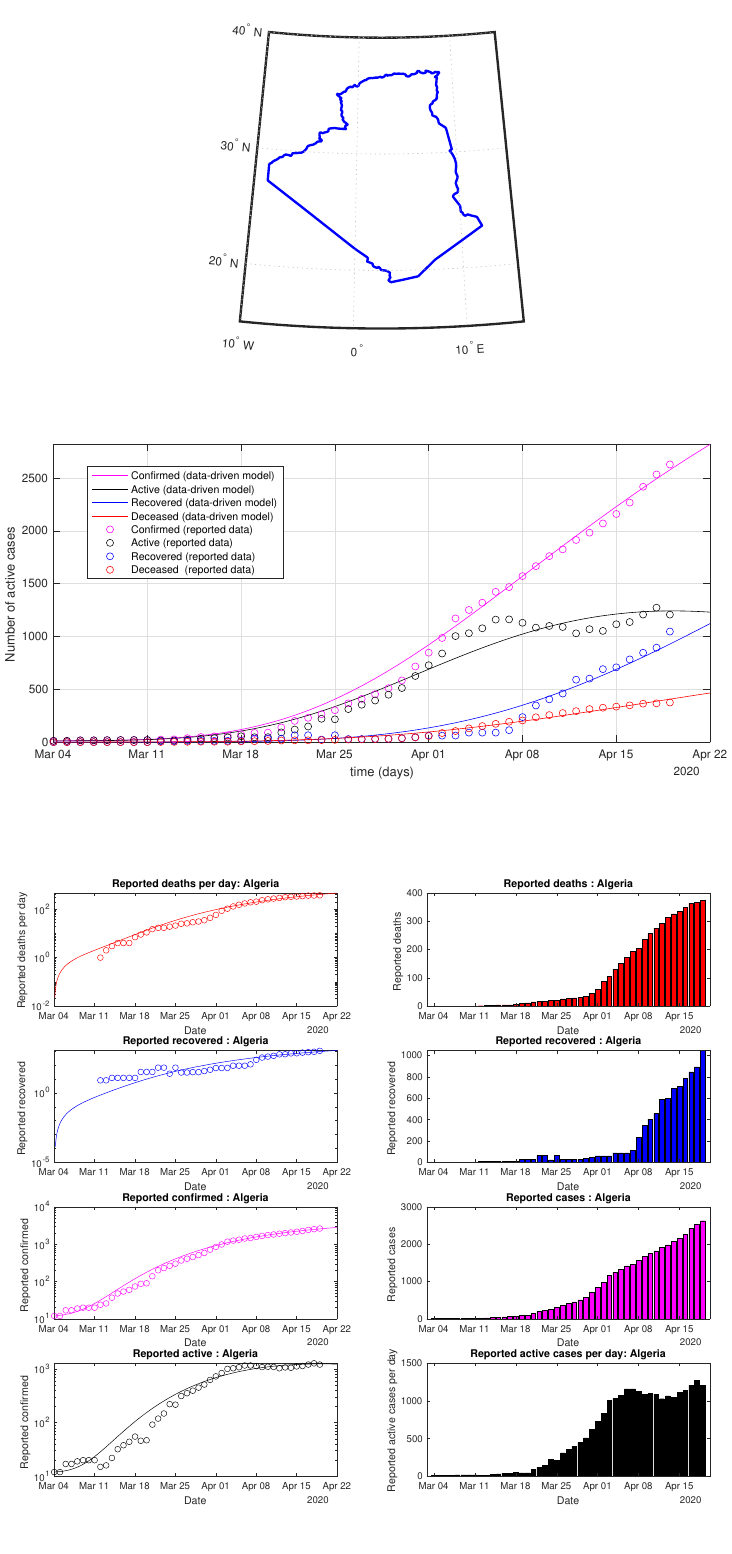
Figure 50. Algeria: data of active, recovered, deceased (in circle or bar) vs. model of active, recovered, deceased over time. Tracking the number of active cases. Predictive analytics for the next couple